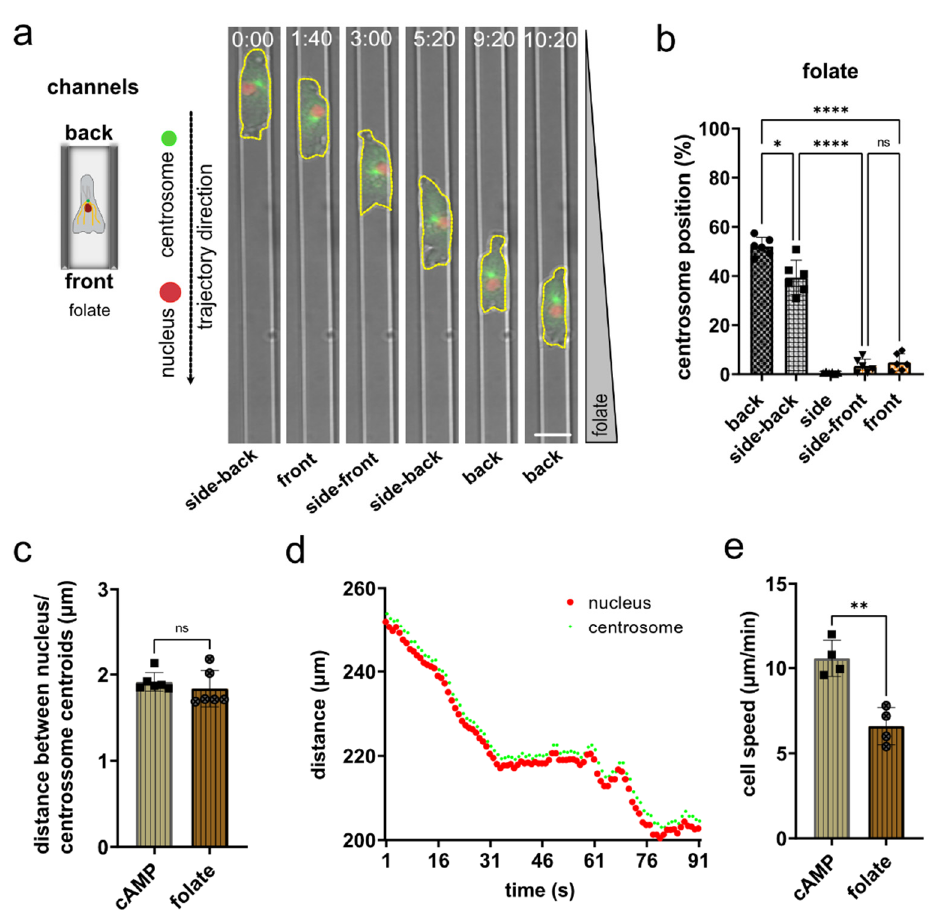
Figure 4. In growth phase Dictyostelium cells migrating in microchannels along a gradient of folate, the centrosome is preferentially located behind the nucleus. ( a ) Scheme (left) and representative microscopy images (right) of a Dictyostelium cell migrating in a microchannel along a folate gradient. The cell shape is highlighted by a yellow dashed line. Images were taken with 10 s-frame intervals. Time is indicated in min and s at the top. ( b ) Quantification of the centrosome position during migration in microchannels along a gradient of folate. N = 6, number of cells = 40. ( c ) Quantification of the distance between nucleus and centrosome of Dictyostelium cells migrating in microchannels in a folate gradient ( n = 6, cells = 40). ( d ) Displacement of tracks for nucleus (red) and centrosome (green) recorded for one cell over time. ( e ) Migration speed in microchannels determined for growth phase Dictyostelium cells moving along a gradient of folate and for aggregation competent cells moving in a gradient of cAMP. * p < 0.05, ** p < 0.01, **** p < 0.0001 are significant, and ns = not